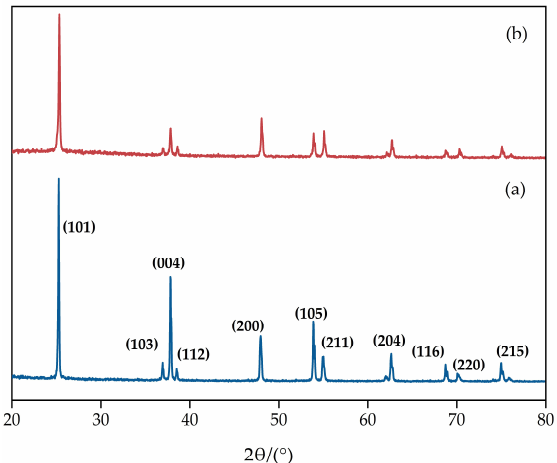
Figure 1. XRD diagram of anatase (TiO 2 ) with exposed (001) facets ( a ) and anatase (TiO 2 ) with exposed (101) facets ( b ).